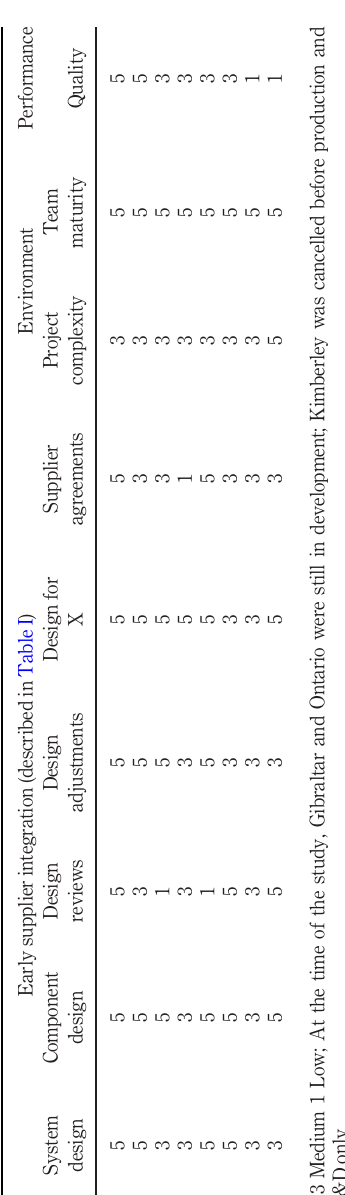
Table V. Supplier involvement levels, environment and quality